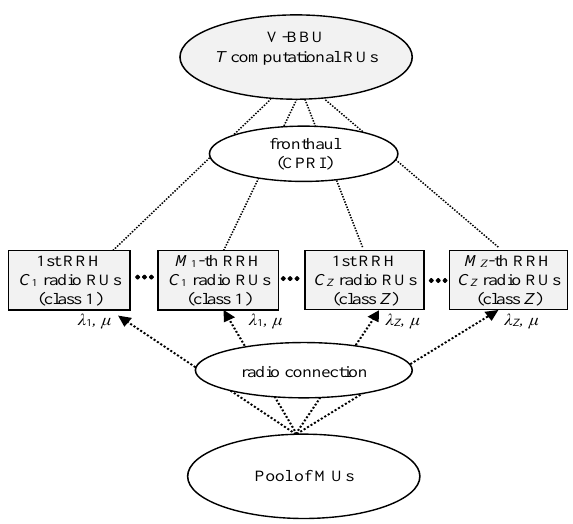
Figure 1. Multi-cluster C-RAN in the case of random traffic (SC-MC model).